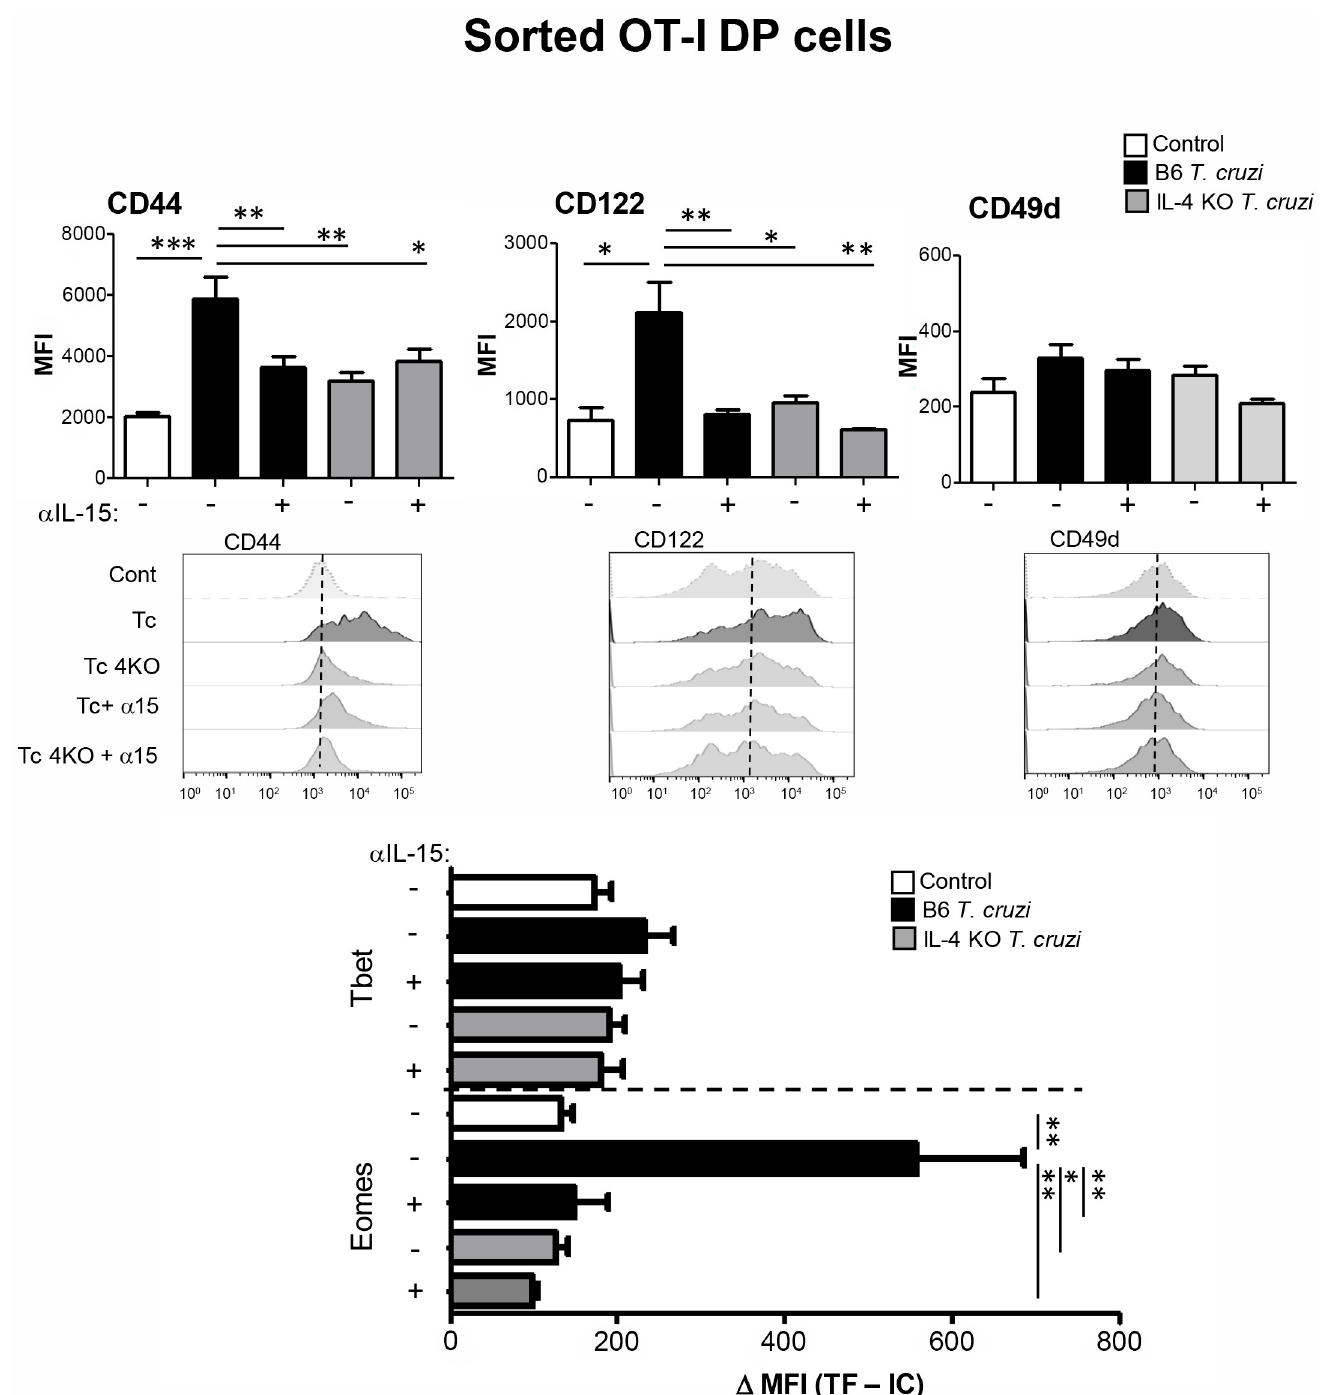
Fig 11. Blockage of IL-4 and IL-15 inhibits the induction of the innate phenotype in DP thymocytes. A bulk populationof CD45.2 + thymocyteseither from WT control, WT T . cruzi- infected(Tulahuen) or IL-4KO T . cruzi- infected(Tulahuen) mice were obtained at day 14 post-infection and cultured for 2h at 37˚C in the presence of PMA/ionomycin. Cells were washed twice and co-cultured with sorted DP cells from OT-I (V β 5 + OVA-tetramer + ) control mice at a 1:1 ratio in the presence or absence of a neutralizing anti-IL-15Ab. After 48h, thymocytes were obtained and CD44, CD122, CD49d, Eomes and Tbet expression were analyzed by Flow cytometry only in DP CD8 OVA-specific OT-I thymocytes. Eomes or Tbet were measured by intranuclear staining using Flow cytometry analysis and were expressed as the differenceof the mean fluorescence intensity (MFI) of Eomes or Tbet vs the MFI of the correspondent isotype control (IC). Histograms are representative of two independent experiments with 3–6 mice/experiment. The statistical test applied was a One-way ANOVA. T . cruzi vs the rest of the groups, � p < 0 . 05 , �� p < 0 . 01and ��� p < 0 . 001 .Tc = T . cruzi ;Tc + α 15= T . cruzi + anti-IL-15 neutralizing Ab; Tc4KO = IL-4 KO T . cruzi ;Tc4KO+ α 15= IL-4 KO T . cruzi + anti-IL-15 neutralizing Ab.